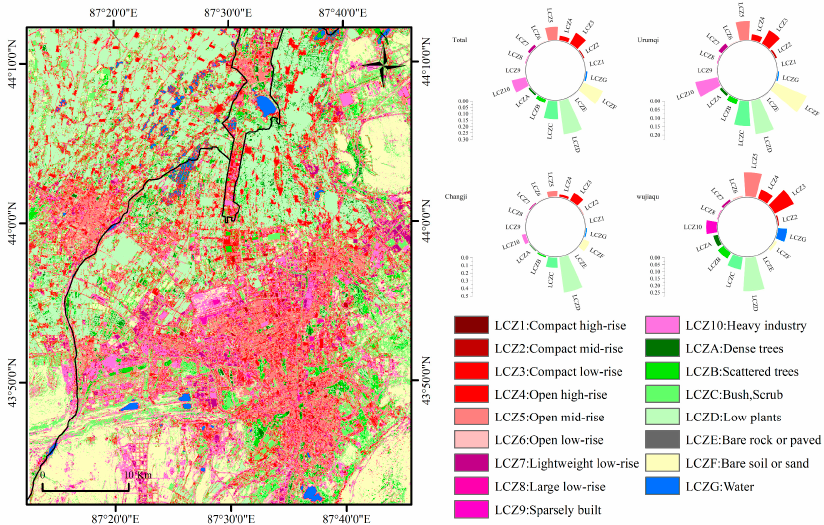
Figure 7. Local climate zone map. Table 6. Local climate zoning accuracy evaluation